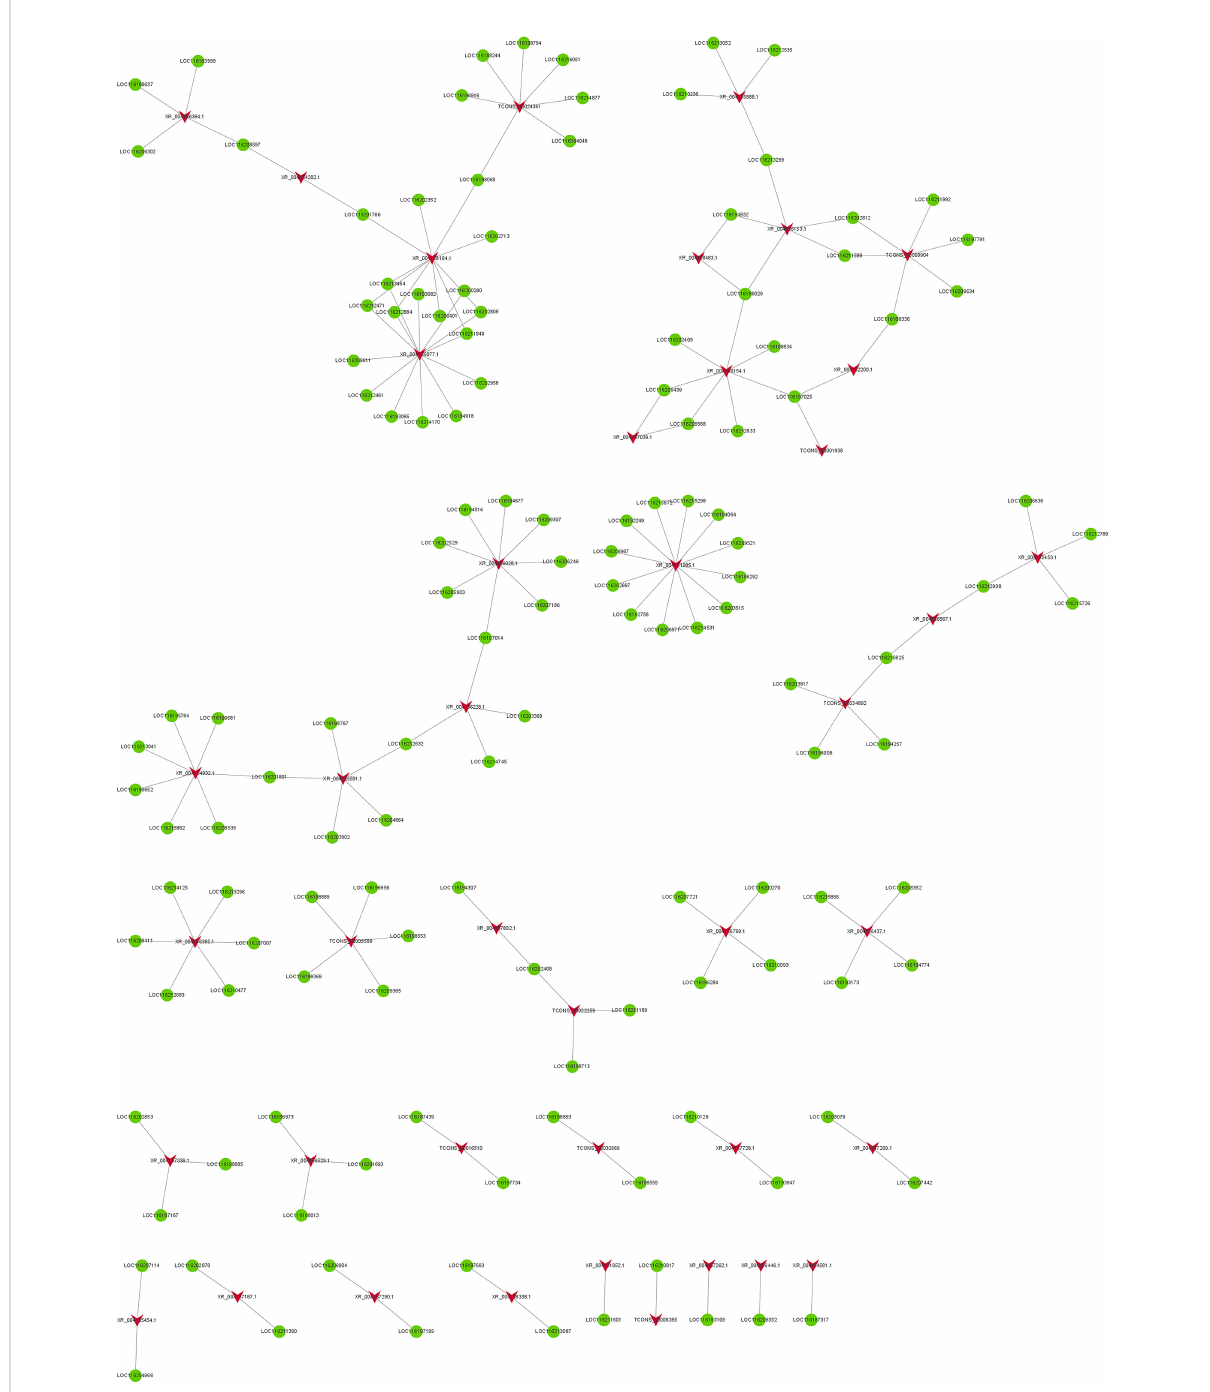
FIGURE 6 The co-expression network of differentially expressed lncRNAs (DELs) and differentially expressed mRNAs (DEGs) in FC vs FNC. The red arrow node and the green circular node represent DELs and